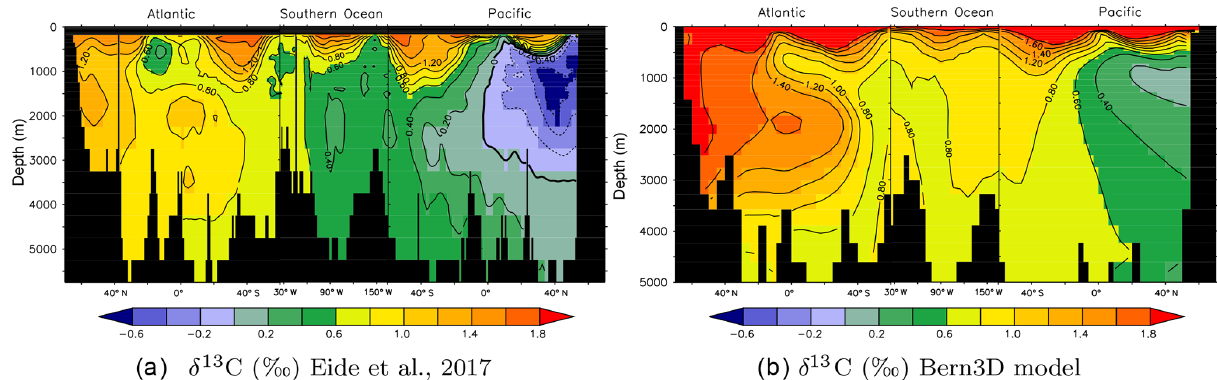
Figure 2. Observed (a) versus simulated (b) preindustrial δ 13 C DIC distributions along a cross section through the Atlantic (25 ◦ W), across the Southern Ocean (58 ◦ S), and into the Pacific (175 ◦ W). (a) Data from Eide et al. (2017) based on ocean measurements and corrected for the Suess effect. (b) δ 13 C as modeled in the Bern3D model under preindustrial boundary